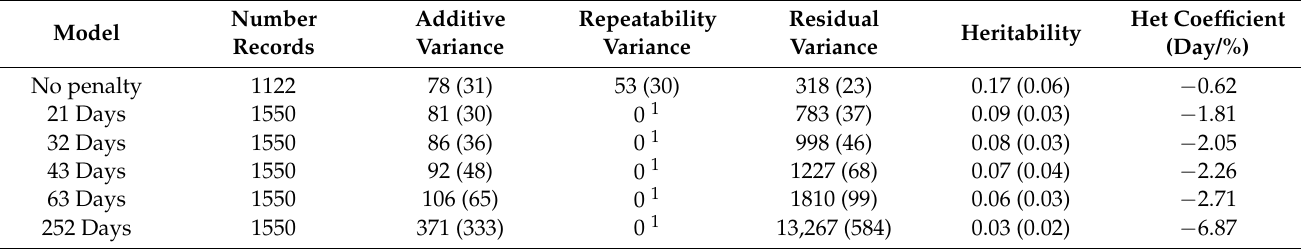
Table 6. Variance Components, heritability and heterozygosity (Het) coefficient of DC2+ (including J2) with different penalty values with standard error in